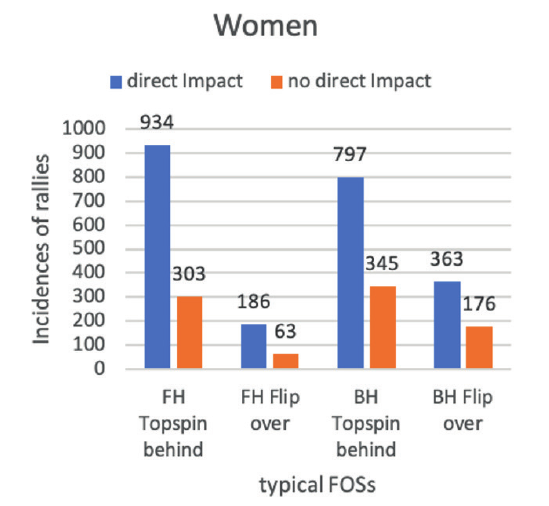
Figure 8. Incidences of typical FOSs separated by impact of FOS for women.